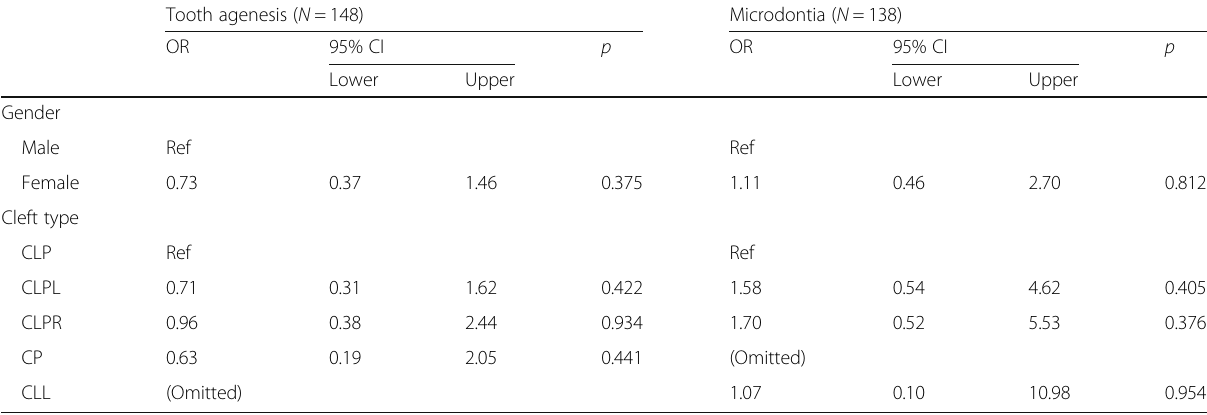
Table 3 Odds ratios (95% CI and p ) for the association of tooth agenesis and microdontia with gender and cleft type (mutually adjusted)